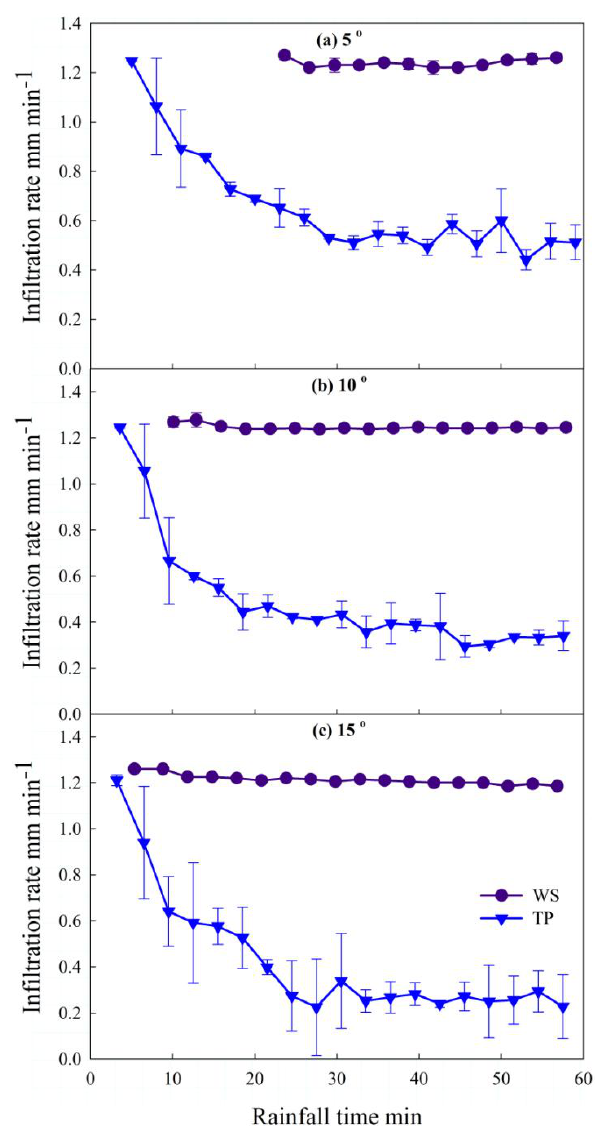
Figure 3. Dynamics of the infiltration rate in WS and TP plot during the simulated rainfall